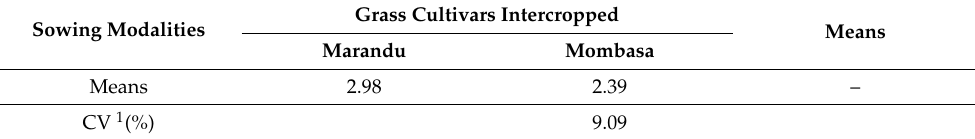
Grass Cultivars